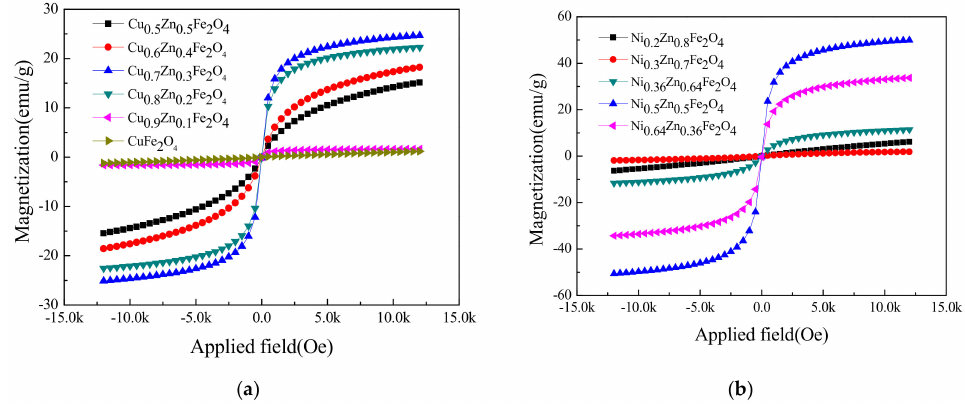
Figure 3. Hysteresis curves of [M x Zn 1 − x ] Fe 2 O 4 at different compositions and proportions. ( a ) [Cu x Zn 1 − x ]Fe 2 O 4 ; ( b ) [Ni x Zn 1 − x ]Fe 2 O 4